Question: Condense the content of this figure into a single sentence.
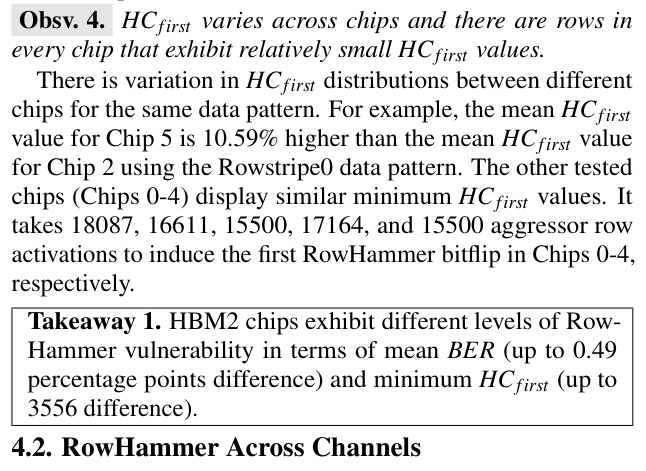
Answer: shows the distribution of BER (y-axis) across different DRAM rows for a given data pattern (x-axis) in a channel (color-coded).